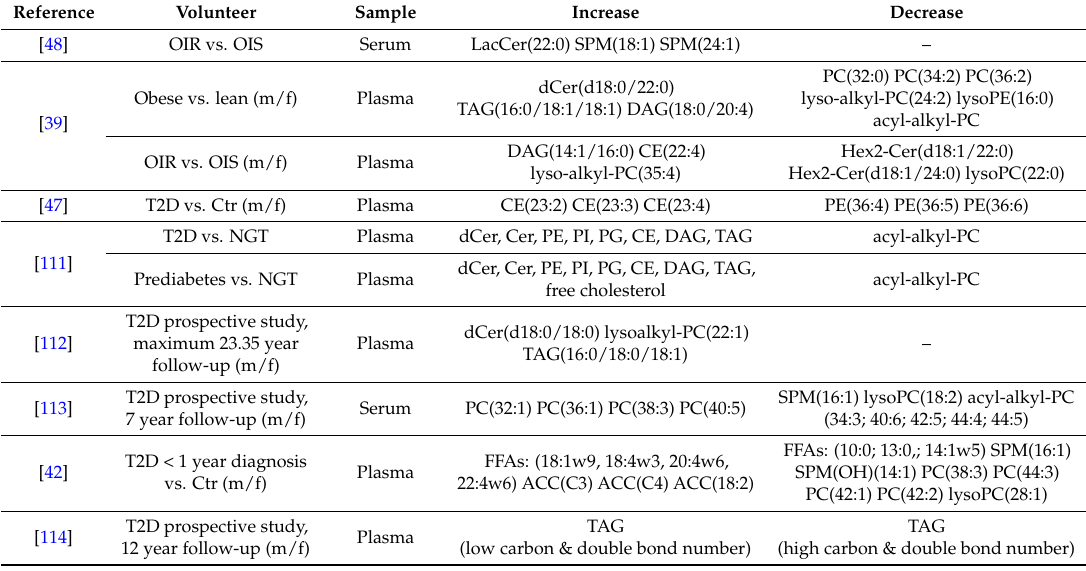
Table 1. Lipid biomarker discovery in T2D and